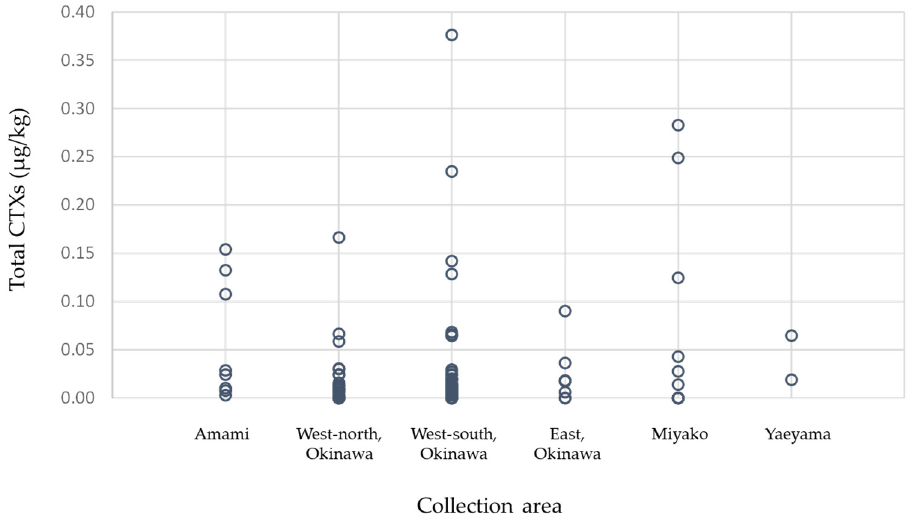
Figure 5. Total CTX levels in the flesh of V. louti collected at various sites as shown in Figure 2.